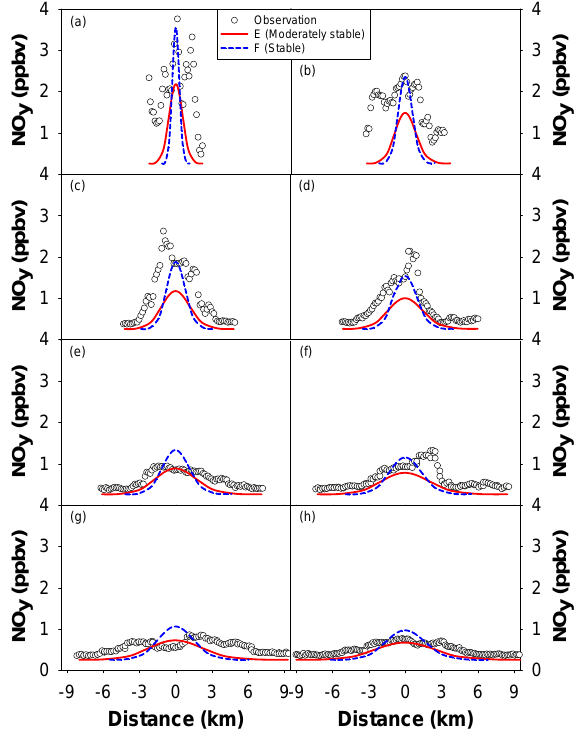
Fig. 5. As Fig. 4, except for NO y .